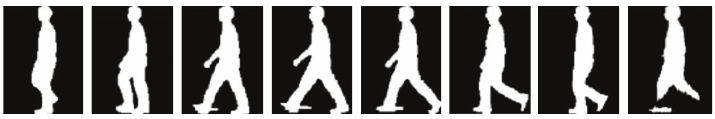
Figure 4: Examples of normalized and aligned gait image.